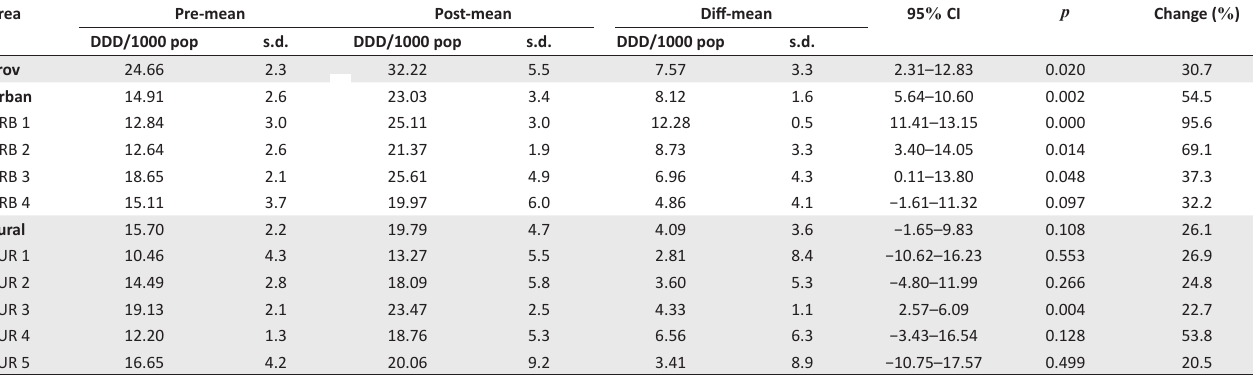
TABLE 2: Mean consumption per quarter and change in the consumption of lamotrigine pre- and post-policy implementation, 2018–2020. Area Pre-mean Post-mean Diff-mean